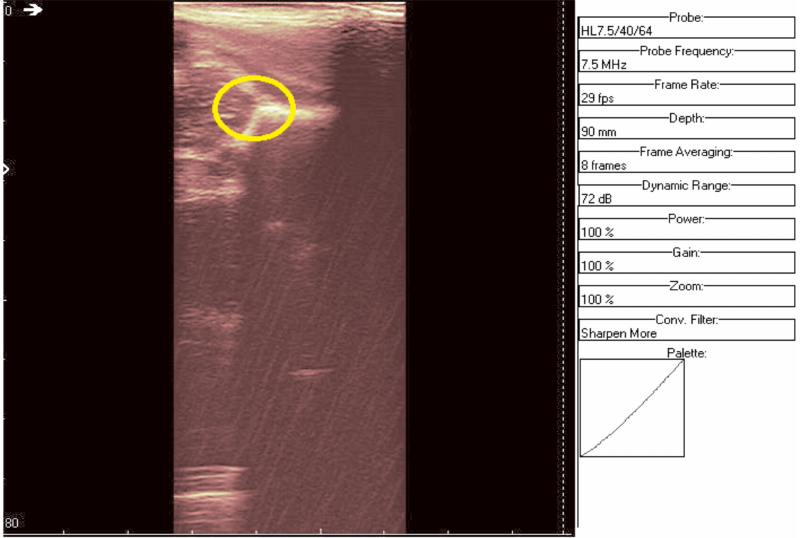
Figure 4. Original data with an added color palette. A region of interest containing some speckle grains was encircled in